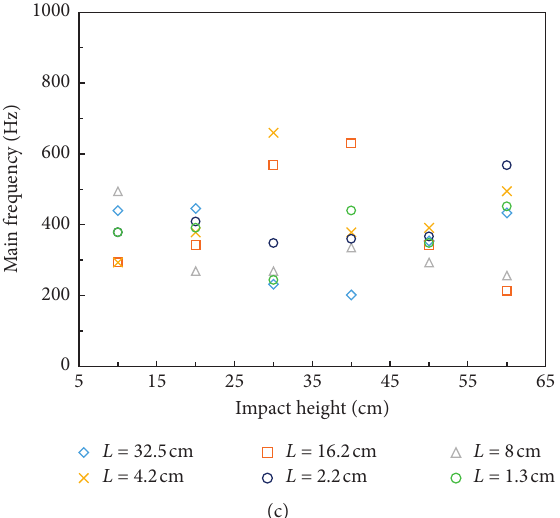
Figure 13: Relationship between the impact height and (a) amplitude of the first wave, (b) frequency of the first wave, and (c) main frequency for Teflon of different lengths.